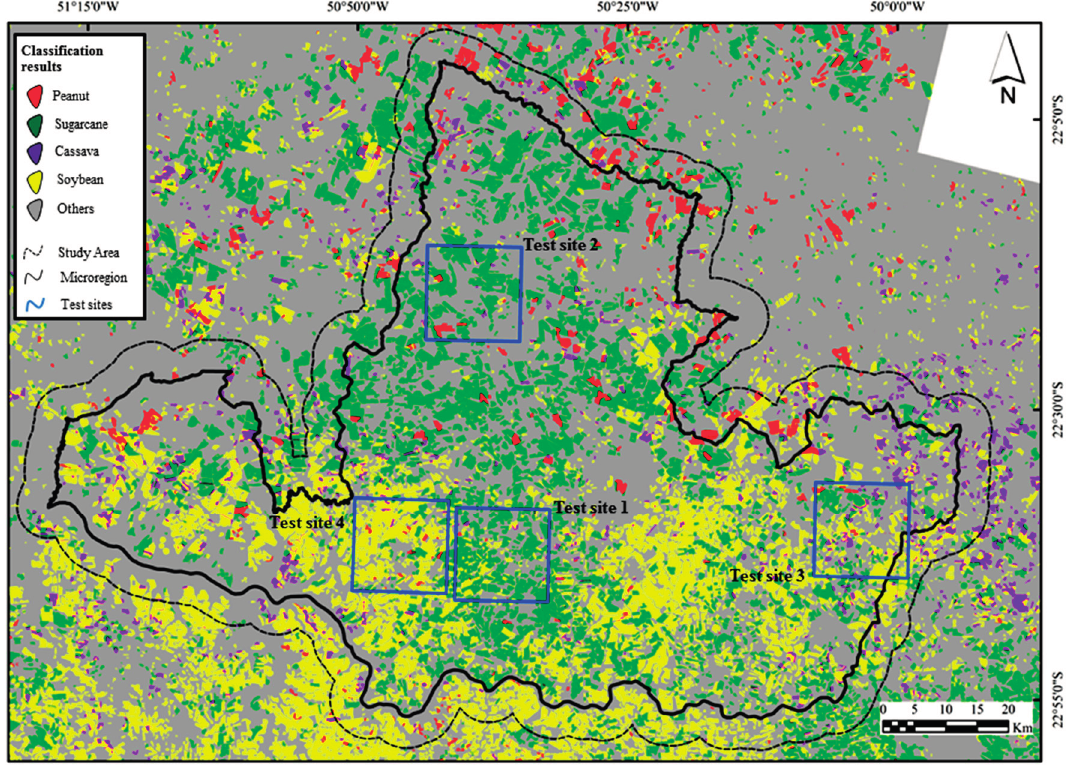
Figure 8. Classification results obtained for the study area using the optimum segmentation and RF classification model identified using the (OOB) statistics (e.g., scale = 70, shape = 50 and compactness = 90). The blue rectangles indicate areas for which complete coverage (manually digitized) reference information is available (see Figure